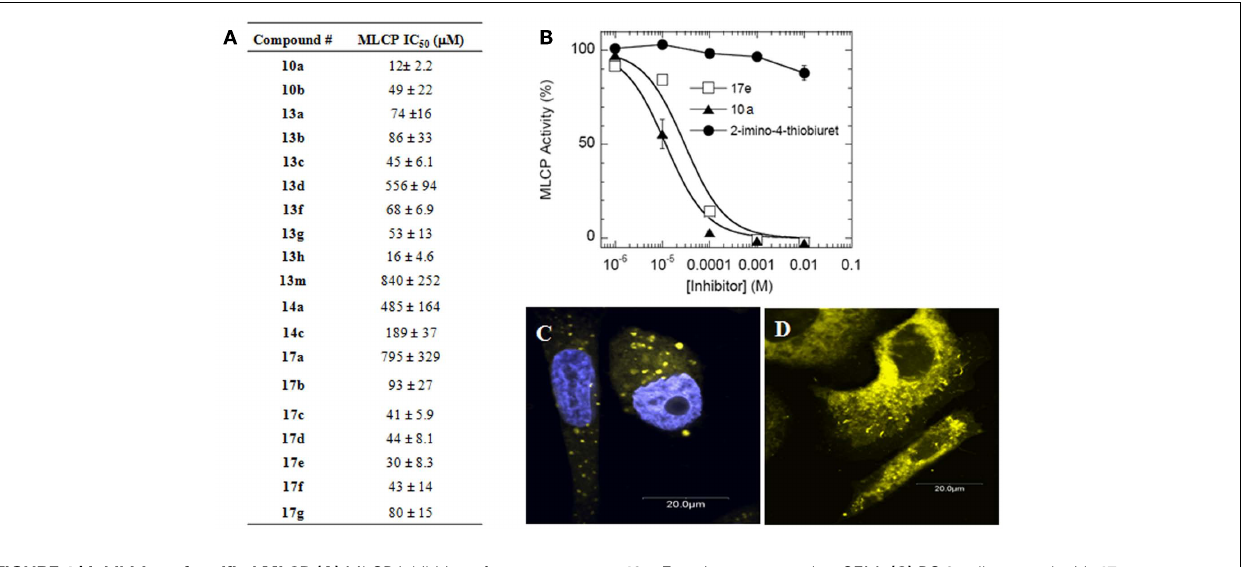
FIGURE 4 | Inhibition of purified MLCP. (A) MLCP inhibition of compounds from Figure 3B . Assay was performed with 32 P-MLC as a substrate. (B) Representative MLCP inhibition graph showing 2-imino-4-thiobiuret as a guanidine group control compound to 17e and